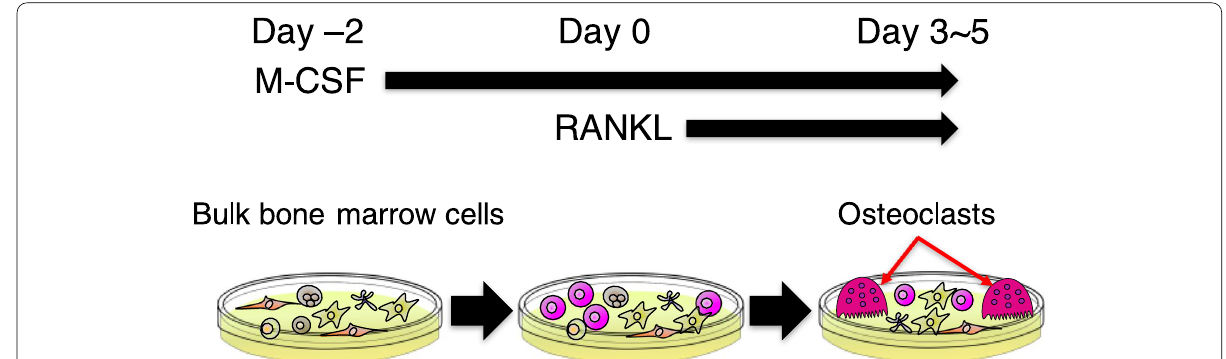
Fig. 1 Schematic of the osteoclast culture system. Murine bulk bone marrow cells are treated with M-CSF for 2 days, and then, these cells are stimulated with RANKL in the presence of M-CSF. Osteoclasts appear in the culture system after 3–5 days of RANKL stimulation. The osteoclast culture contains heterogeneous populations of cells, only a portion of which is able to differentiate into mature